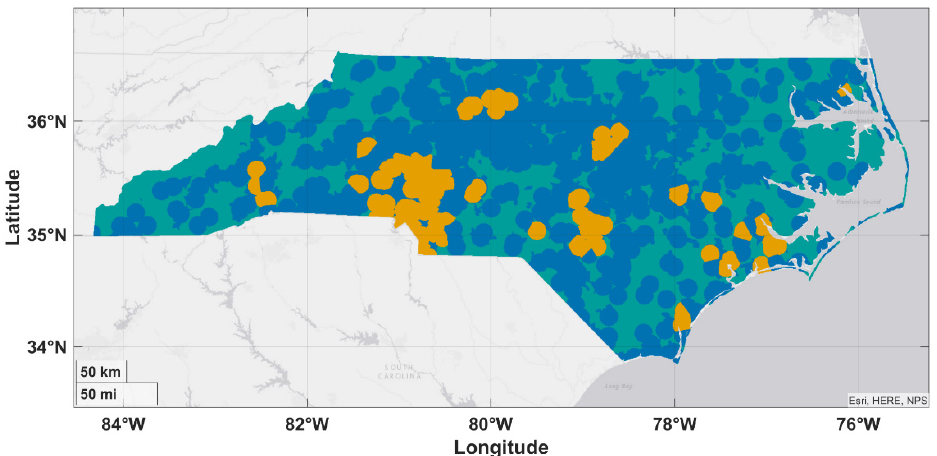
Figure 1. Airspace segmentation map of North Carolina for altitudes of 0–499 feet above ground level (AGL); low regions are visualized in green, medium in blue, and high in orange. The majority of the airspace was classified as medium or high. This map is dependent upon generalized operations defined by airspace class, population density, and aerodromes. It is completely independent of the OpenSky Network and its ground